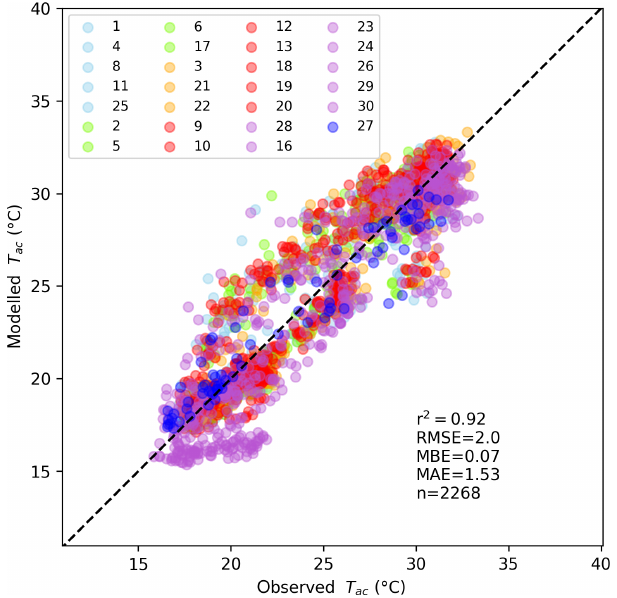
Figure 7. Modelled T ac vs. observed T ac for Mawson Lakes weather stations (15–16 February 2011, 30min data). The numbers and colours correspond to individual stations and clusters shown in Fig.